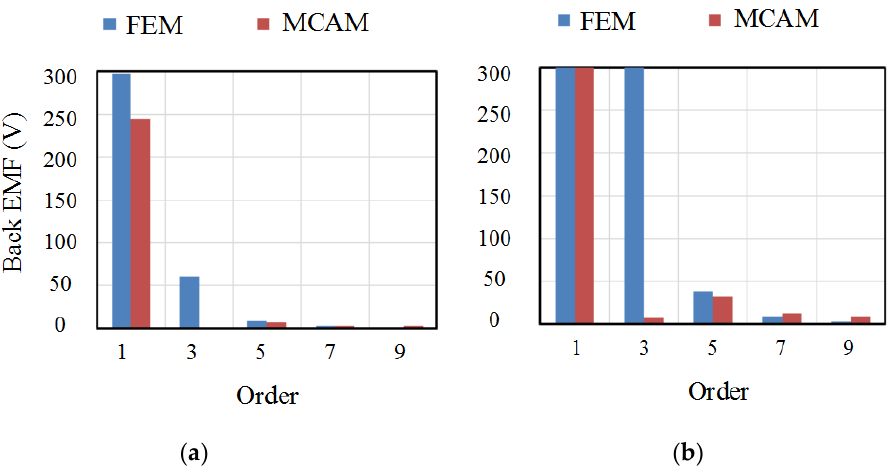
Figure 6. Comparison of back-EMF harmonic analysis results of the AFPMSM. ( a ) Overall picture. ( b ) Partial enlargement picture.